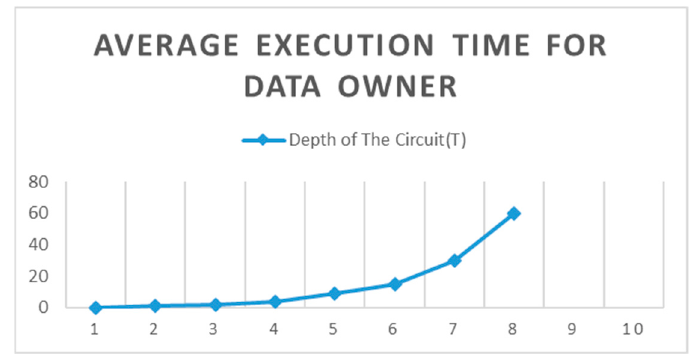
Figure 9. Average execution time for the data owner.